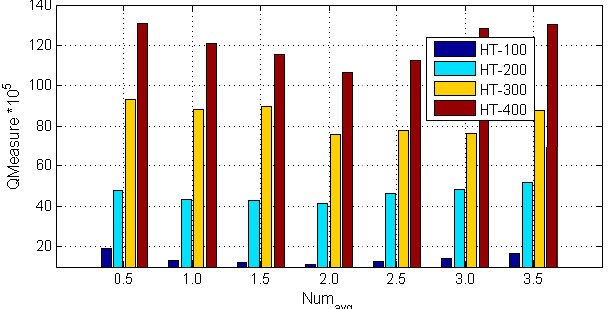
Figure 8. QMeasure values under different avg Num .